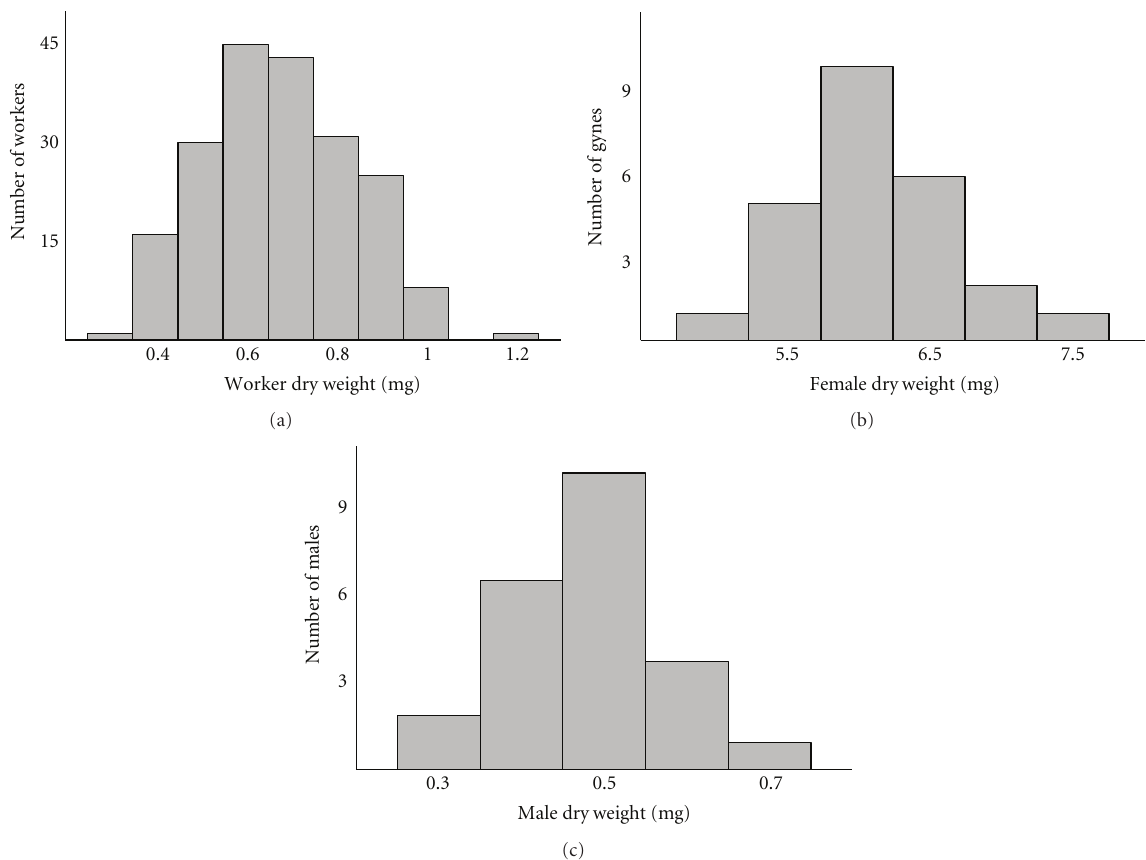
Figure 5: The dry weights of three adult A. rudis castes. (a) workers, n = 200; (b) gynes, n = 25; (c) males, n = 25.